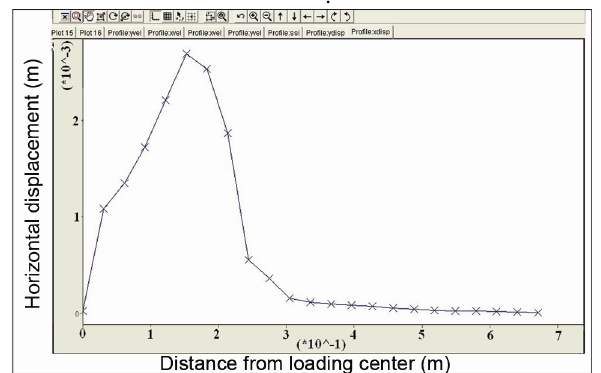
Fig. 3. Horizontal displacements of dynamic loading versus the distances from loading plate center (FLAC output) Horizontal and vertical Displacements of dynamic loading versus distances from central loading point are plotted in Figs 3 and 4. These figures indicate that displa- cements beyond 550 mm distance from the loading plate center considerably decrease. Therefore, with respect to loading plate radius of 150 mm, the minimum distance between the side of the loading plate and the wall of the box will be 400